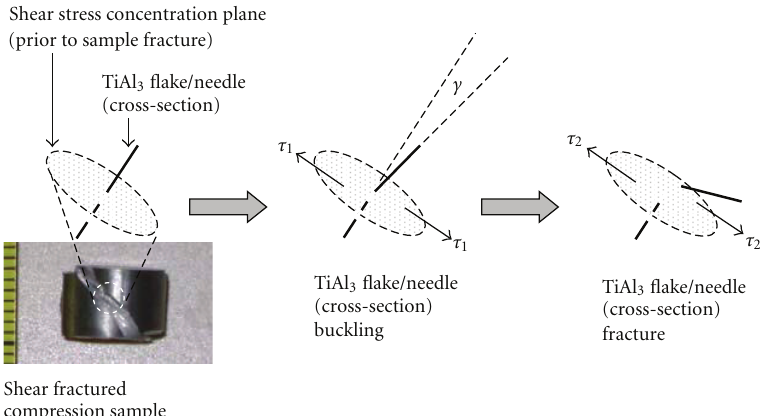
Figure 6: Schematic diagram illustrating compressive shear buckling of brittle TiAl 3 flake/needle in AZ31/AZ91/TiC nanocomposite. τ 1 and τ < τ γ (exaggerated) represents very low angular deflection of the brittle TiAl τ 2 represent planar shear stresses where 1 2 . 3 flake/needle during buckling. Table 4: Results of compressive testing of AZ31/AZ91 and AZ31/AZ91/TiC nanocomposite. 0.2%CYS UCS Plastic failure strain WOF Material (MPa) (MPa) (%) (MJ/m 3 ) a AZ31/AZ91 117 ± 15 495 ± 13 AZ31/AZ91/1.5vol% TiC 104 ± 13 ( − 11) 531 ± 11 (+7) 20 . 3 ± 2 . 7 (+4) 94 ± 2 (+15) a Obtained from engineering stress-strain diagram using EXCEL software. () Brackets: indicate % change with respect to corresponding result of